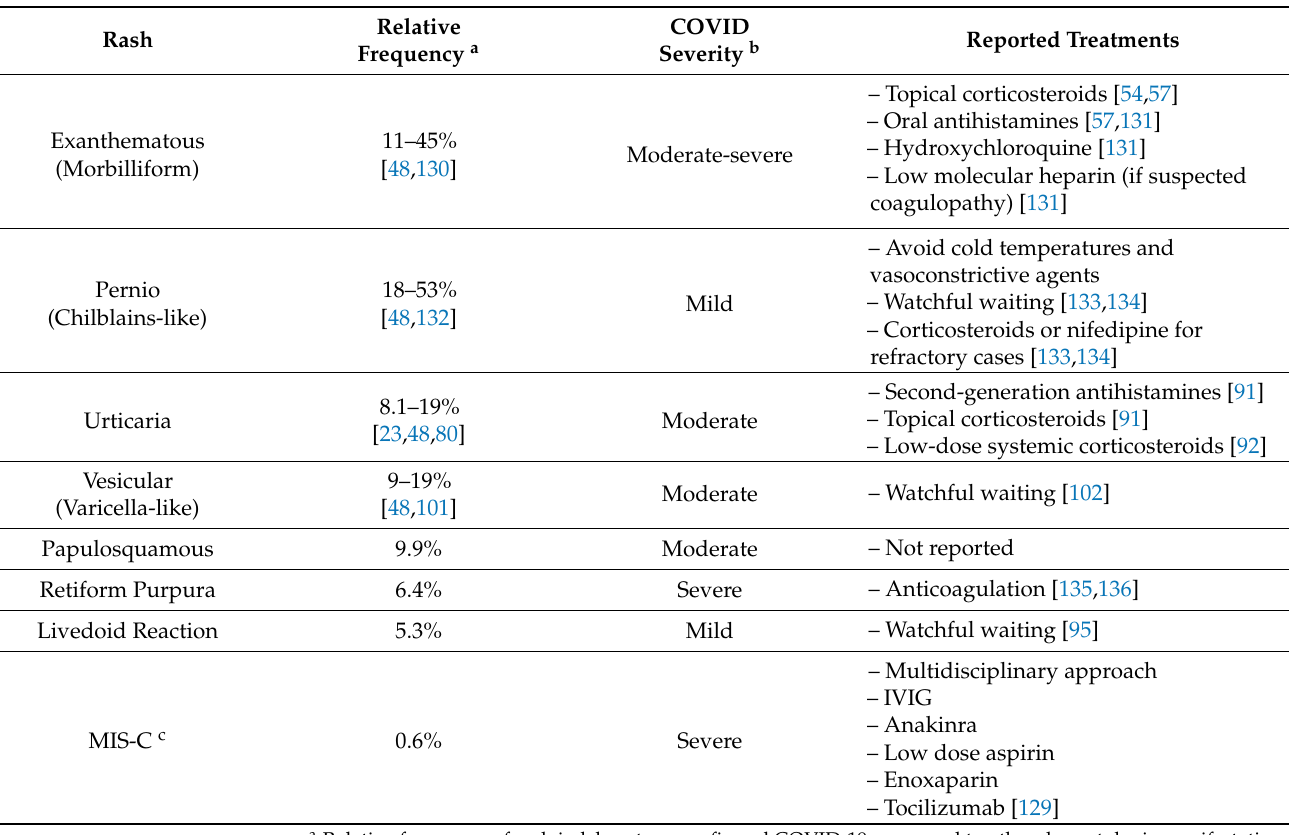
Table 1. Characteristics of Common COVID-19-related Dermatologic Manifestations.